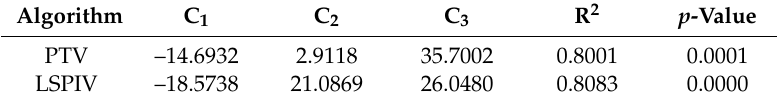
Table 7. Parameters and statistics of multiple linear regression analysis.